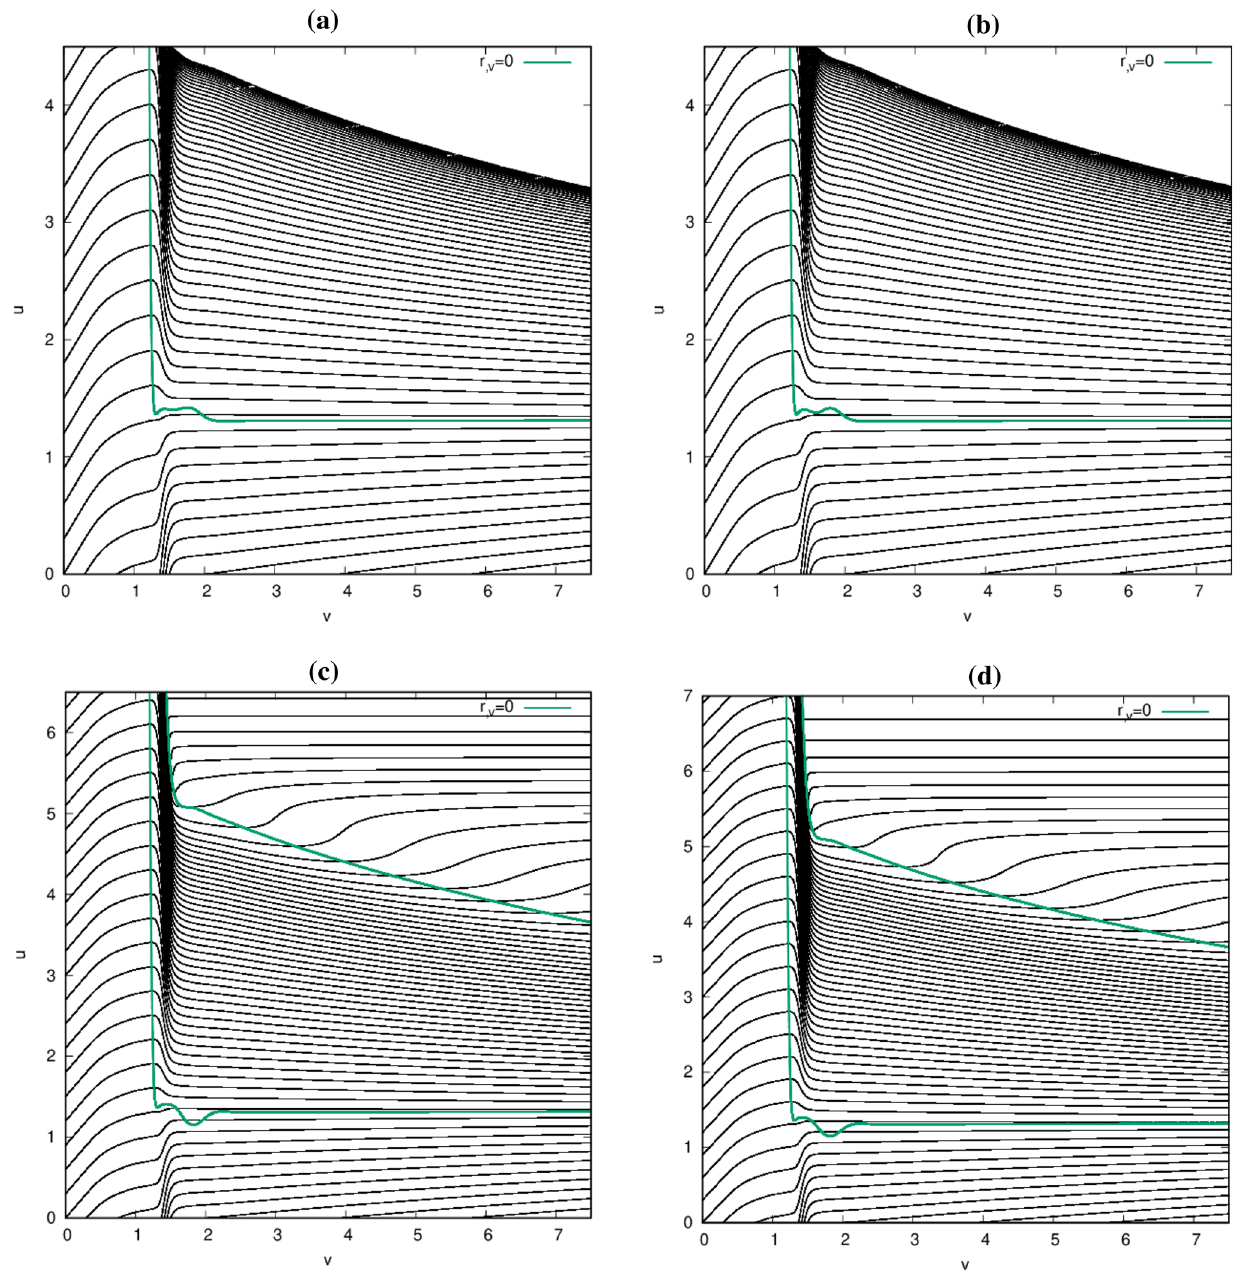
Fig. 9 Penrose diagrams of spacetimes emerging from evolutions with non-minimal scalar–gravity couplings. The parameters λ hX and ξ = ξ . 1 and − 0 . 5, respectively. The field amplitudes X h were equal to 0